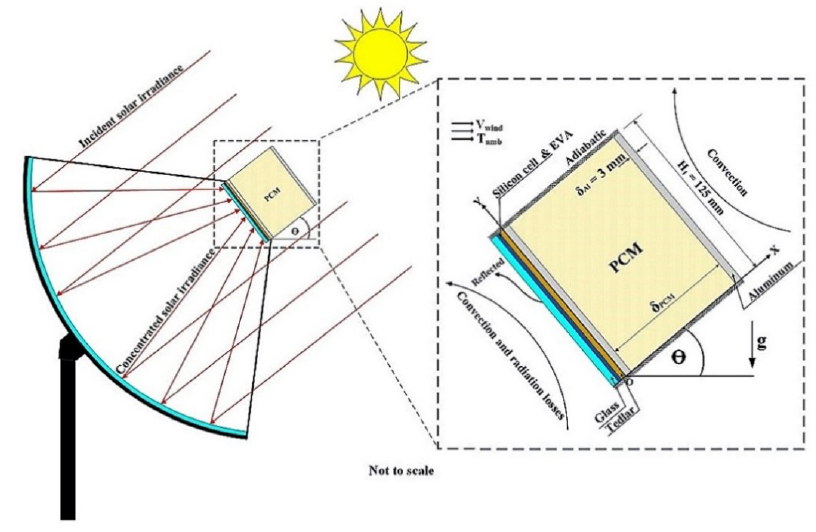
Figure 14. Schematic of CPV-Phase Change Material (PCM) system [85].